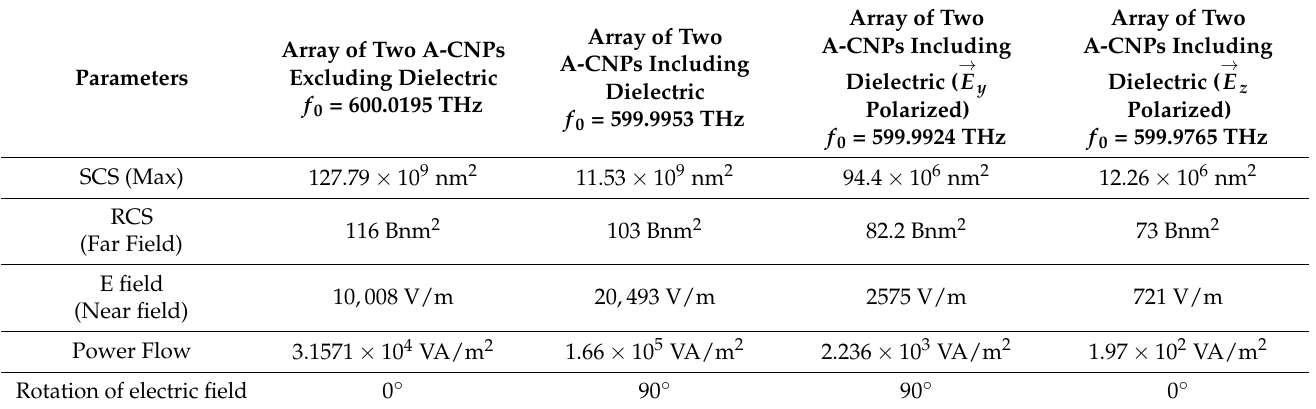
Table 1. Comparison of optical properties for the two basic configurations I and